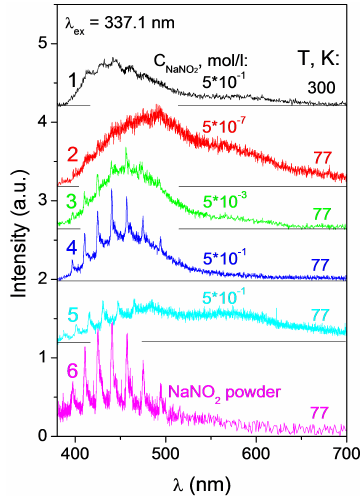
Figure 5. The PL spectra of the cellulose–NaNO 2 composite sam- ples #4, Cell-NO, (1–5) and NaNO 2 powder (6); λ ex = 337 . 1nm; T = 300 (1) and 77K (2–6). The concentrations of the NaNO 2 salts in water solutions were 5 × 10 − 1 (1, 4, 5), 5 × 10 − 3 (3), and 5 × 10 − 7 molL − 1 (2). The spectra 4 and 5 were taken for the sample areas shown in Fig. 1d and 1e,